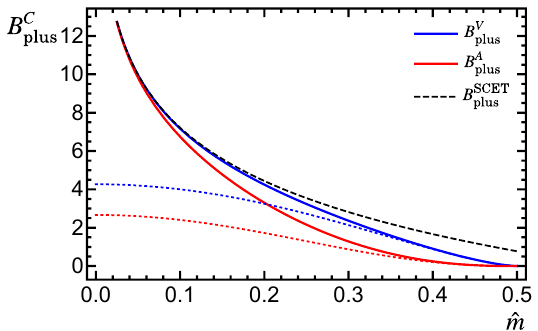
Figure 16 . The universal coe(cid:14)cient of the plus distribution B C mass ^ m . We show the coe(cid:14)cient in the case of an axial-vector current (red solid line), a vector current (blue solid line) and the SCET limit (black dashed line). The SCET limit agrees with both the full QCD vector and axial cases in the limit ^ m ! 0. We also show the respective threshold limits as dotted lines, expanded up to O ( v 5 ). Both full QCD expressions approach zero in this limit, as